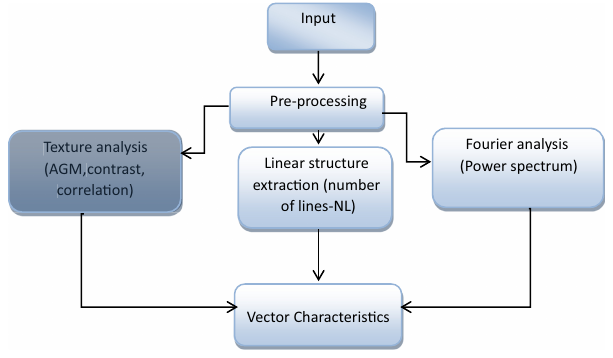
Fig. 2. Block diagram of the image processing